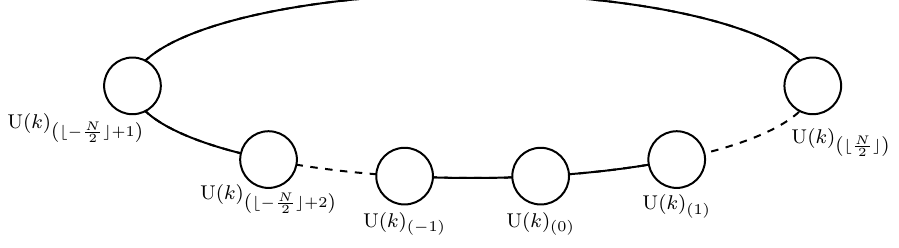
Figure 2 . The quiver diagram corresponding to the system of D4 and NS5